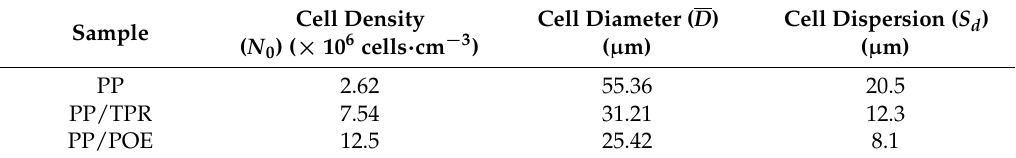
Figure 3. Microstructures of the foamed PP composites: ( a ) pure PP, ( b ) PP/TPR, ( c ) PP/POE. Table 1. The density and diameter of the cells in foamed PP